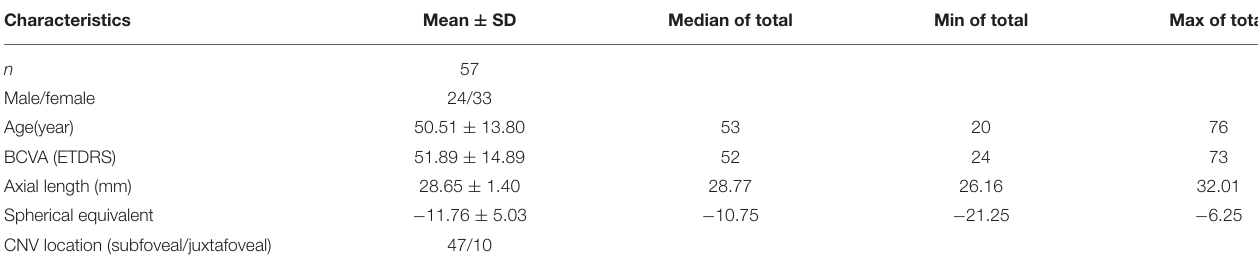
TABLE 1 | Demographic and baseline characters.